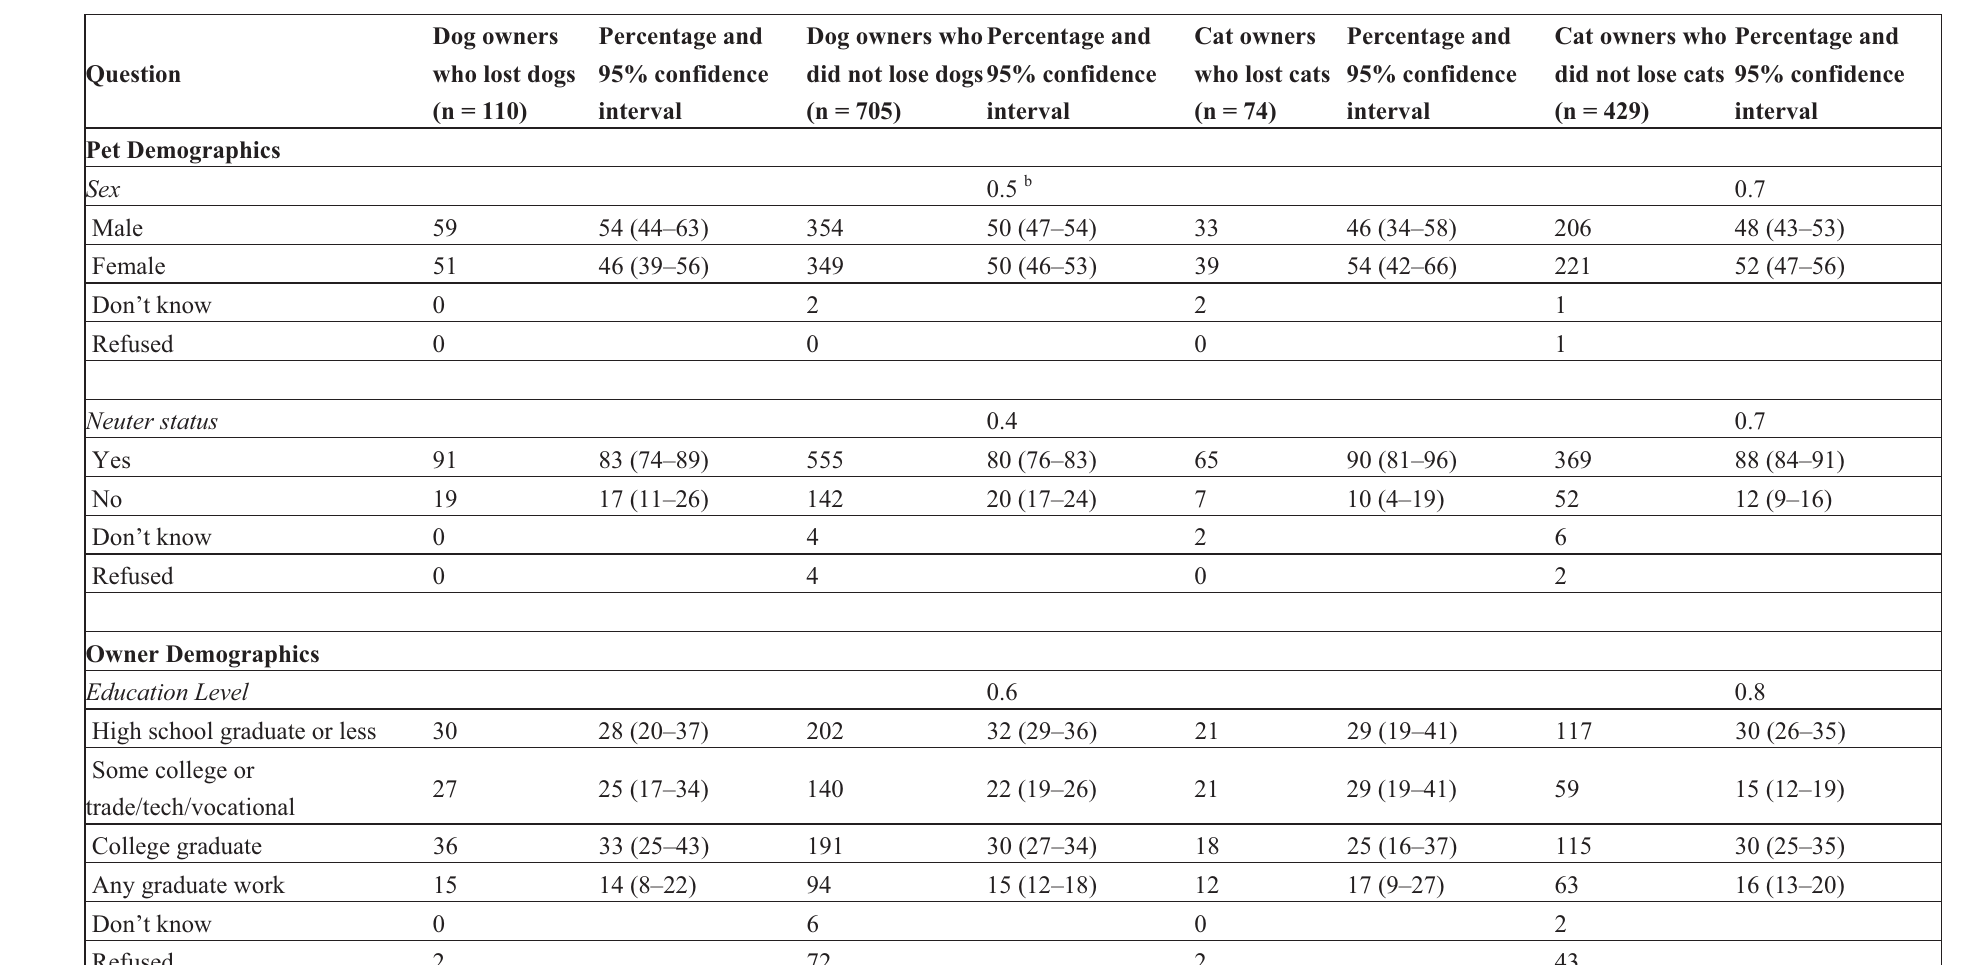
Table 2. Pet and respondent demographic variables analyzed by whether they lost or their pets or not a